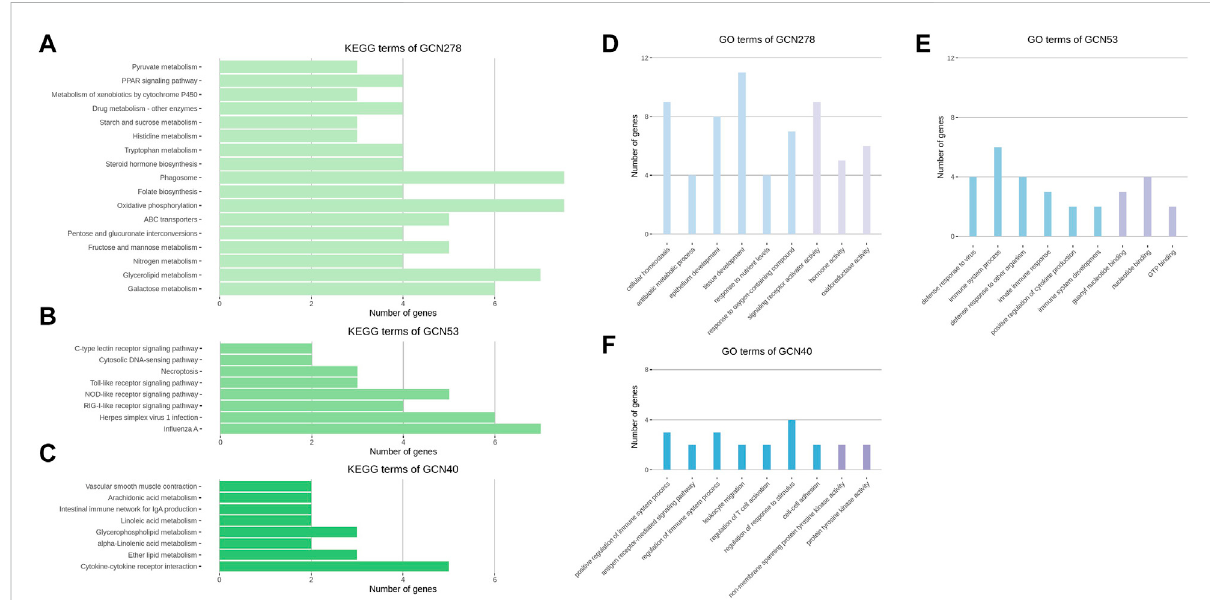
FIGURE 5 KEGG and GO analysis results of three GCNs. (A – C) Enriched KEGG pathways of the GCN278, GCN53, and GCN40 networks. (D – F) Enriched GO termsof theGCN278, GCN53, and GCN40 networks. GO terms werecategorized as abiological process and molecularfunctions (colored blue andpurple,respectively).RepresentativeGOtermswereselectedfrom26,42,and70signi fi cantbiologicalprocesstermsand12,15,and6signi fi cant molecular functions terms for GCN278, GCN53, and GCN40, respectively. (A – F) All enrichment terms passed a signi fi cance cut-off ( p < 0.05) and were sorted in the order of largest signi fi cance